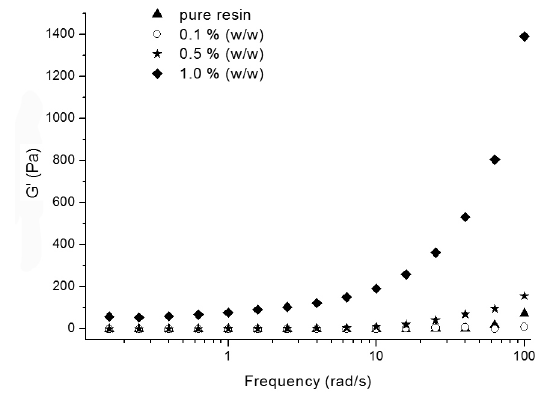
Figure 5. Storage modulus as function of frequency for all formulations of CNTs-epoxy mixtures.